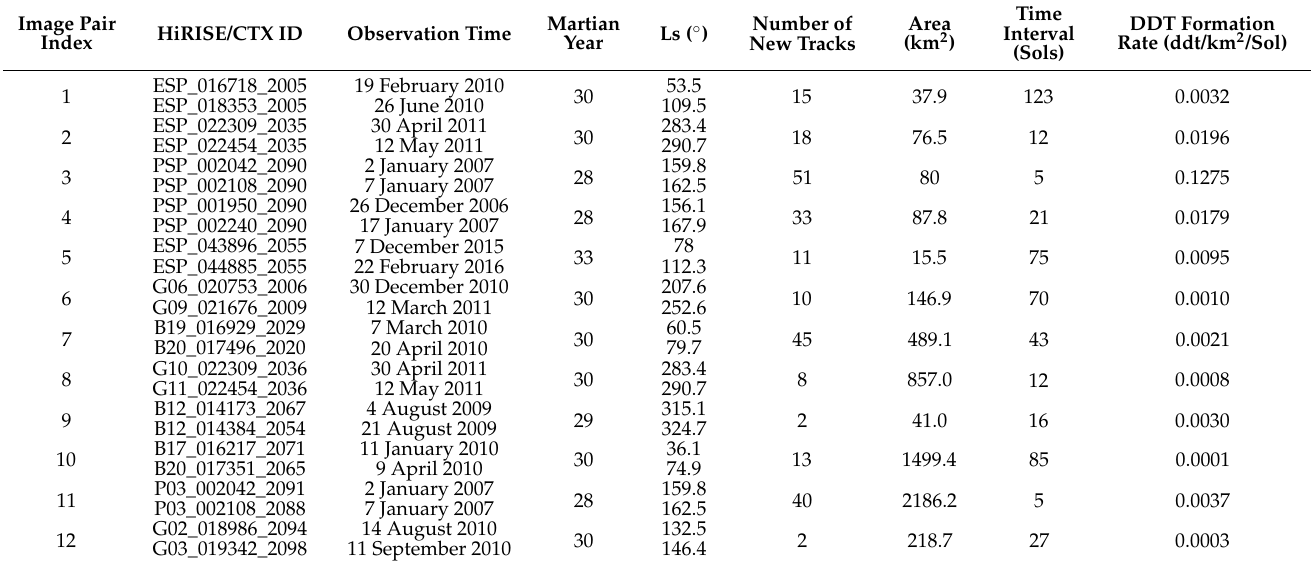
Table 4. Summary of DDT formation rates in 12 image pairs. The image pair index is consistent with that in Figure 2. Image Pair